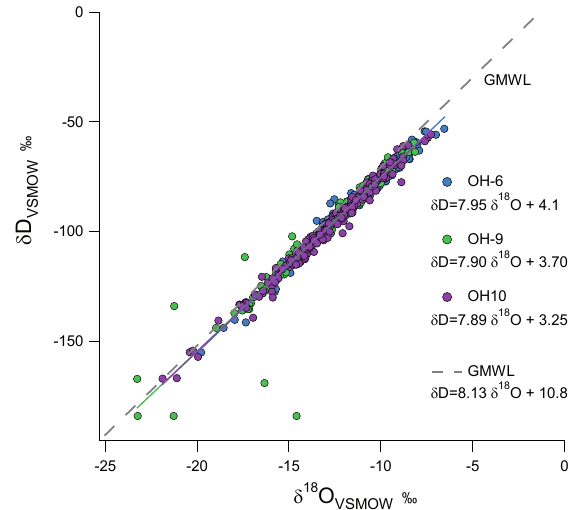
Figure 7. Co-isotopic regression of firn cores OH-6 (solid blue dots), OH-9 (solid green dots) and OH-10 (solid purple dots). All slopes and intercepts are very close to each other as well as to the global and local meteoric water line (GMWL – grey dashed line, and LMWL – black solid line). Stable water isotope analysis for each firn core was made at 5cm resolution, representing 630 sam- ples in total.